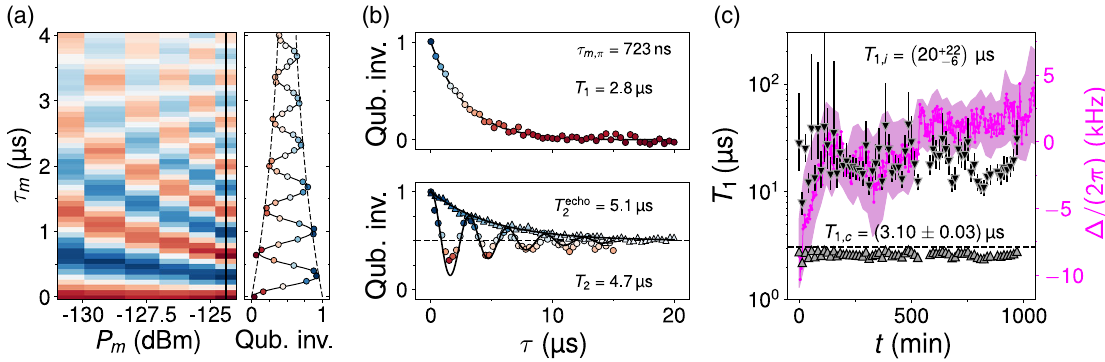
FIG. 4. Time-domain manipulation and measurements of the grAl transmon. (a) Rabi oscillations between the qubit ’ s ground j 0 i and first excited state j 1 i as a function of the average drive power of the Gaussian shaped manipulation pulse P and its duration τ . The m m color scale represents the qubit population inversion from equilibrium (red) to fully inverted (blue). With increasing drive power, the Rabi frequency increases in agreement with the spectroscopy measurement (see Fig. 2 and Appendix C). The right-hand panel shows − 124 . 7 dBm, highlighted in the 2D plot by a black arrow. The black dashed lines indicate an the Rabi oscillation for P m ¼ exponentially decaying envelope. (b) Measurement of the grAl transmon coherence times. The duration of the π pulse is 723 ns at a − 131 . 4 dBm. The markers in the top panel show the measured population inversion at a time τ after the π manipulation power P m ¼ pulse, and the black line indicates an exponential fit with a characteristic energy relaxation time T 1 ¼ 2 . 8 μ s. The bottom panel shows the results of a Ramsey-fringes (circles) and a Hahn-echo (triangles) measurement. The observed frequency of the Ramsey fringes 2 π × 300 kHz of the π pulse. From the fits indicated by solid lines, we extract agrees within 5% with the frequency detuning Δ m ¼ coherence times T 2 ¼ 4 . 7 μ s and T echo 2 ¼ 5 . 1 μ s, as well as the corresponding pure dephasing times 28 and 46 μ s, respectively. (c) Time stability of the energy relaxation time (gray triangles) and the deviation Δ of the qubit transition frequency from its average (pink markers corresponding to the right-hand axis). The pink shaded area is the uncertainty for the qubit frequency measurement. The − T 3 . 1 μ s (dashed line) is the T 1 T 1 = ð T 1 inverted black triangles show the intrinsic energy relaxation time T 1 1 Þ , where T 1 ; κ ¼ ; γ ¼ ; κ ; κ limit due to spontaneous emission into the waveguide. Notably, the T 1 and frequency stability data were taken in different